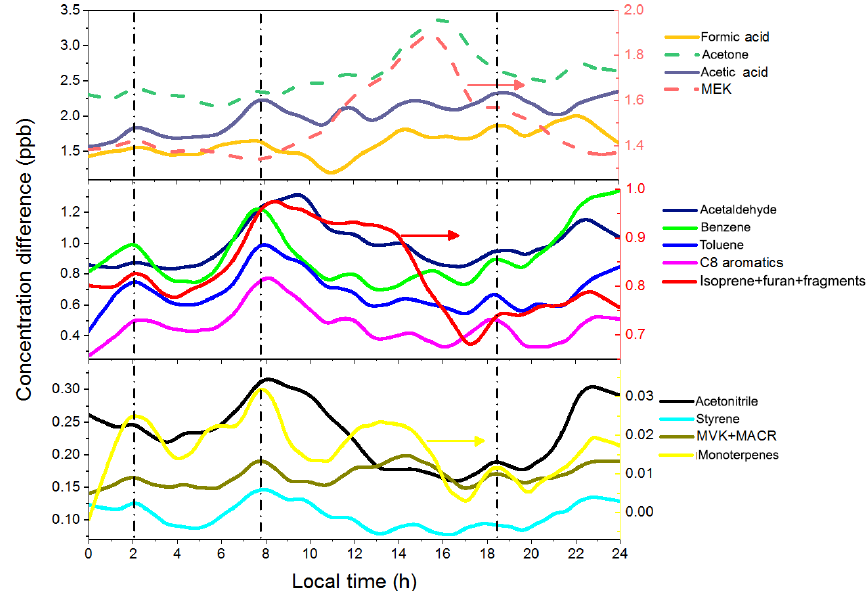
Figure 6. Diurnal variations of the differences in VOC concentrations at urban and suburban sites. The vertical dashed lines indicate the rush hours related to vehicle